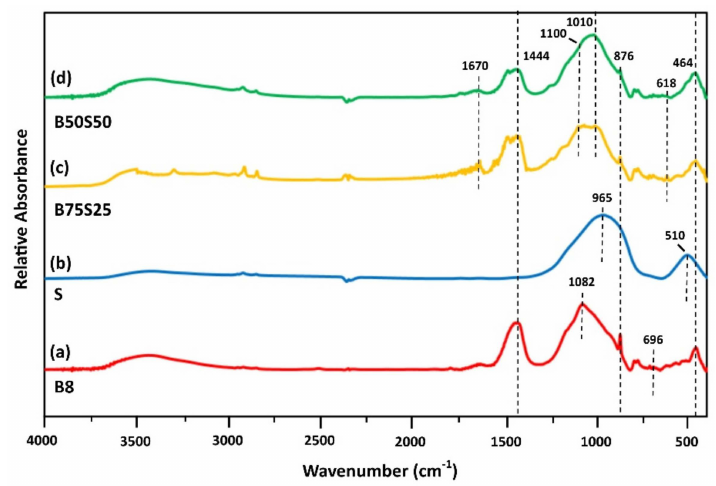
Figure 5. FTIR spectra of IPs ( a ) B8, ( b ) S, ( c ) B75S25 and ( d ) B50S50 (H 2 O / Na 2 O = 18.2, curing at 90 ◦ C, ageing for 7 days).